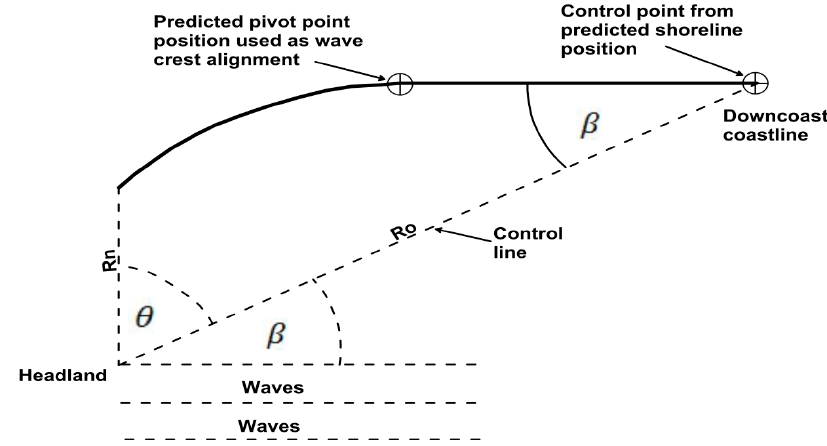
Figure 3. Definition sketch of the parabolic model used to assess equilibrium.